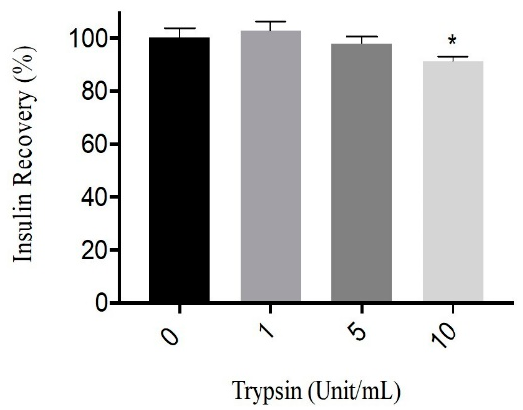
Figure 1. Insulin recovery percentage after incubation (3 h) with 0, 1, 5, 10 Unit/mL of trypsin at 37 °C, pH 7.4. Data are expressed as means ± S.D. ( n = 3), * p < 0.05.